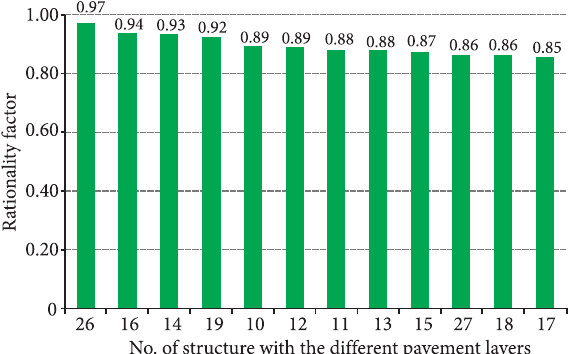
fig. 6. Efficiency coefficient of structures with asphalt pavement from different